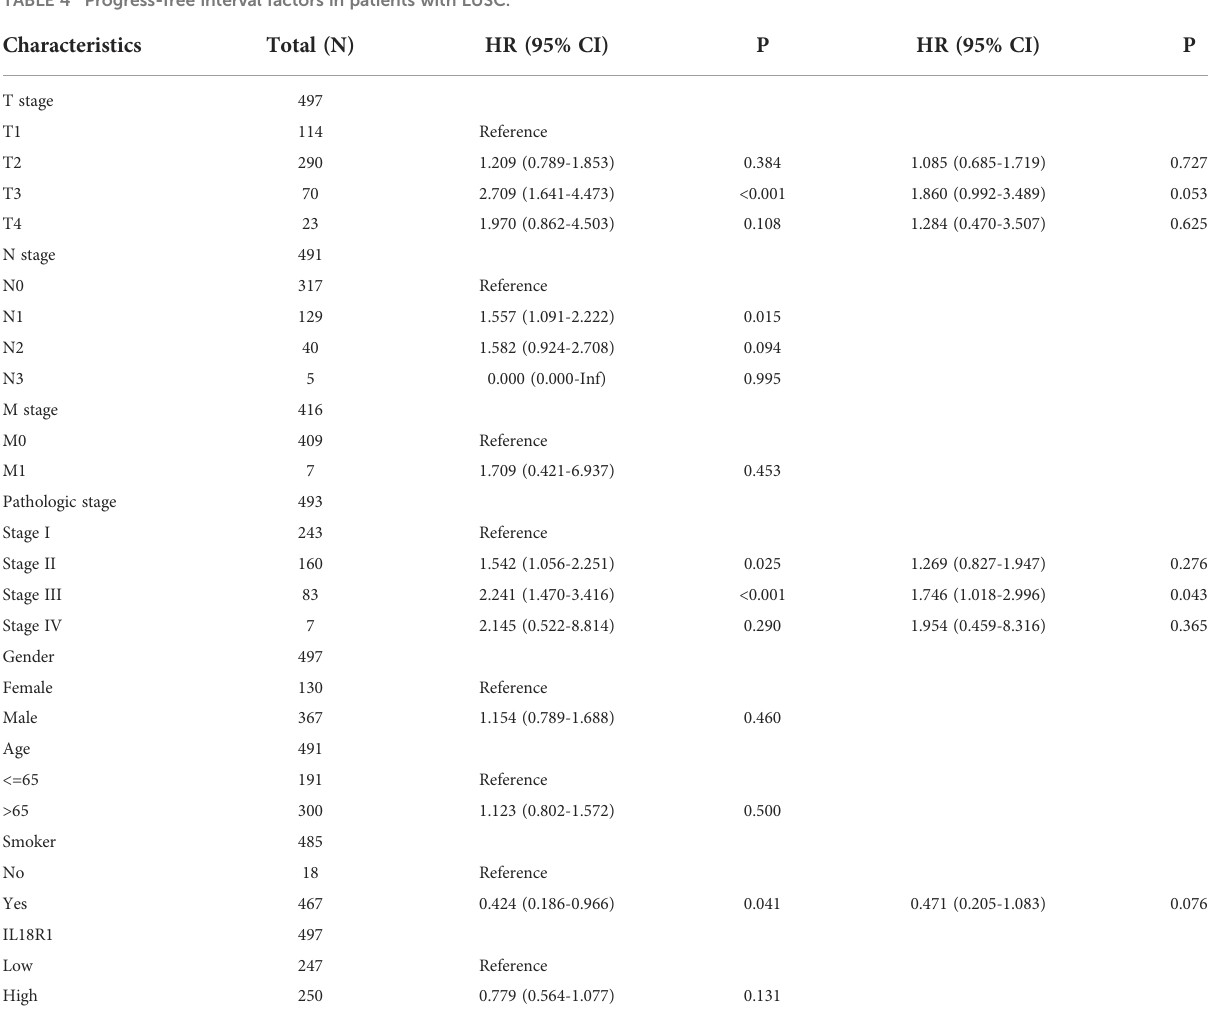
TABLE 4 Progress-free interval factors in patients with LUSC.